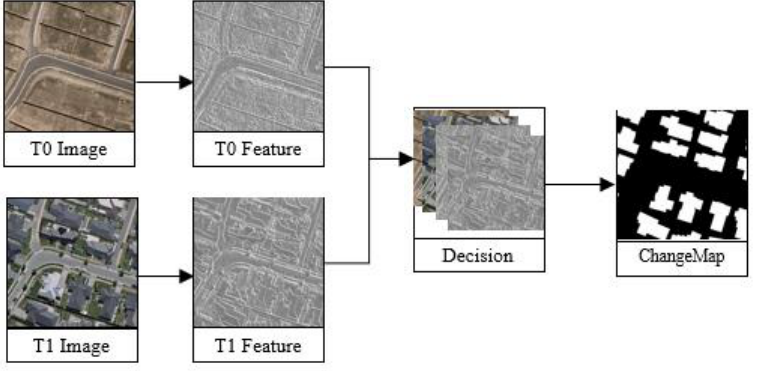
Figure 1. The basic framework for change detection.